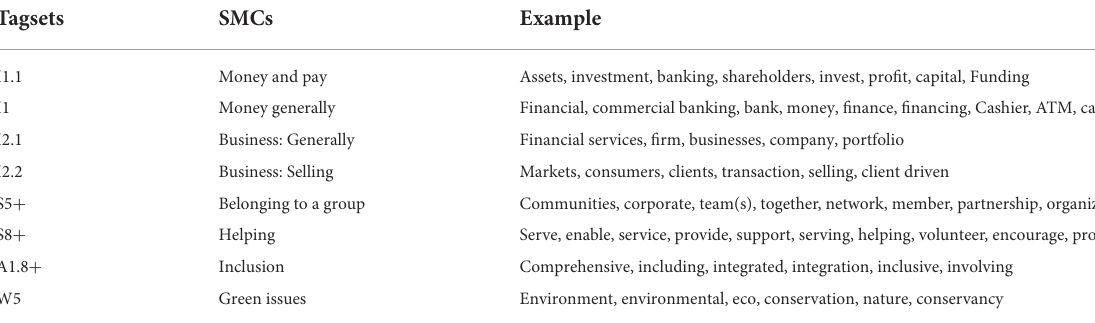
TABLE 4 Typical tokens of the shared SMCs in both CB and